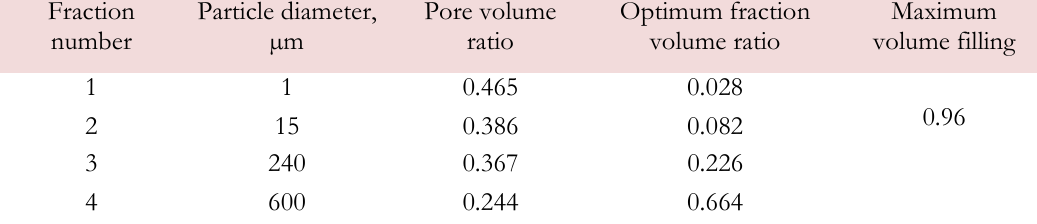
Table 3: Parameter values of mixtures of four silica fractions.